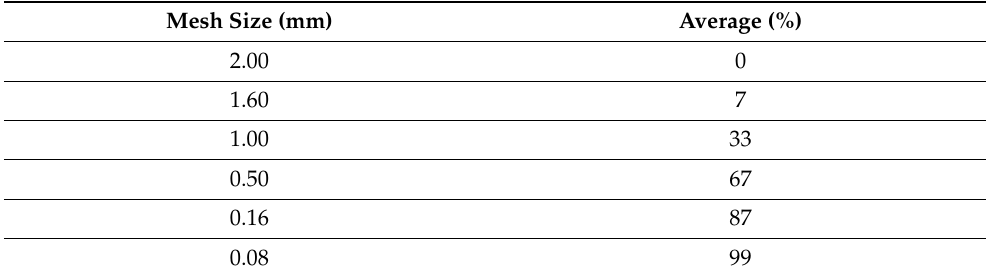
Table 4. Particle size distribution of quartz sand.